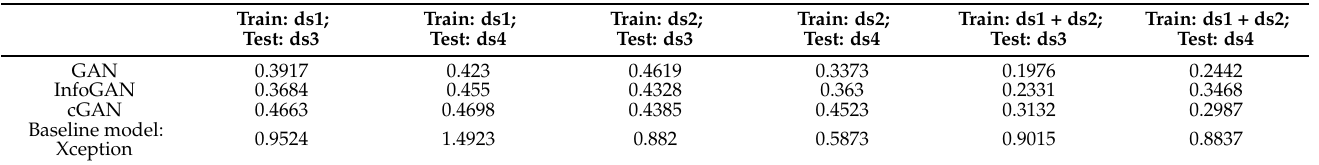
Table 4. Comparative